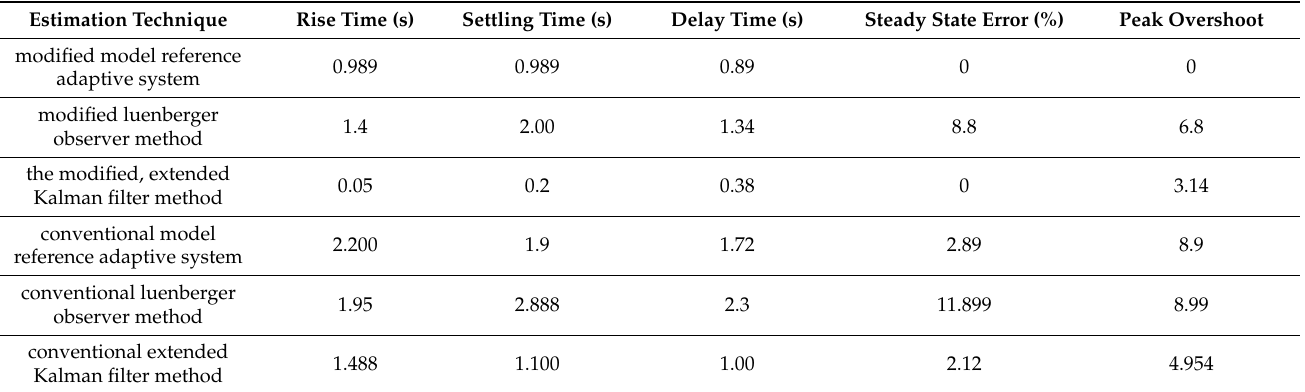
Table 4. Numerical analysis for speed estimation techniques.